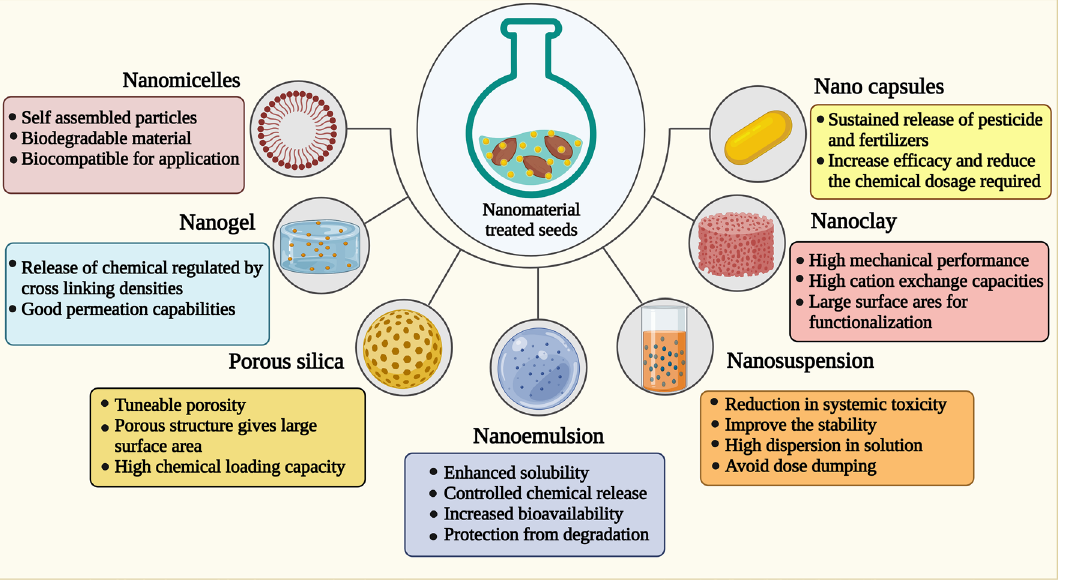
Fig. 4 Next-generation nanoagrochemicals for enhancing seed germination (nanoagrochemicals with a wide range of morphologies and struc- tures such as nanomicelles, nanogels, porous silica nanoemulsion, nanosuspension, nanoclay providing controlling stability, solubility, bioavail- ability, and controlled release of agrochemicals for enhanced seed